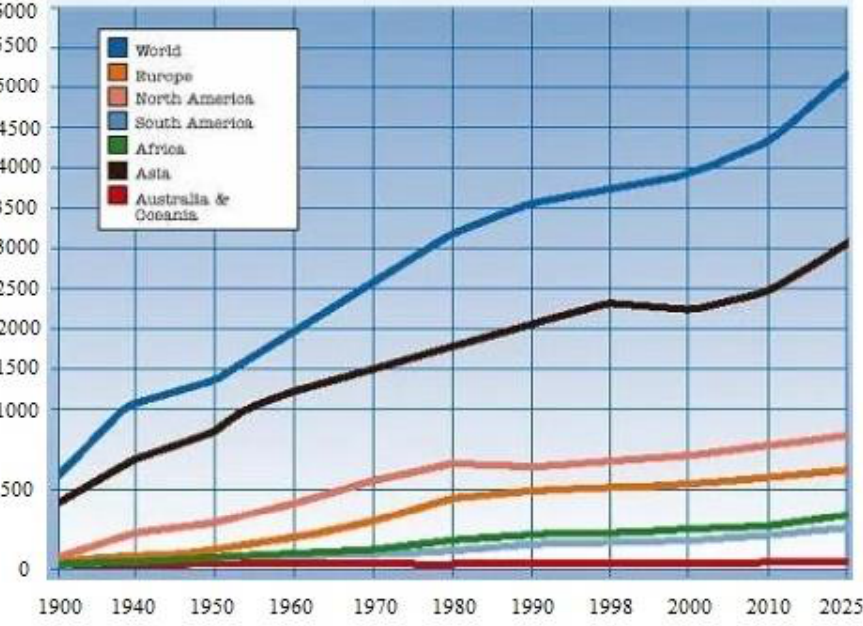
Figure 5. Global water consumption for the years 1900 – 2025 [20].